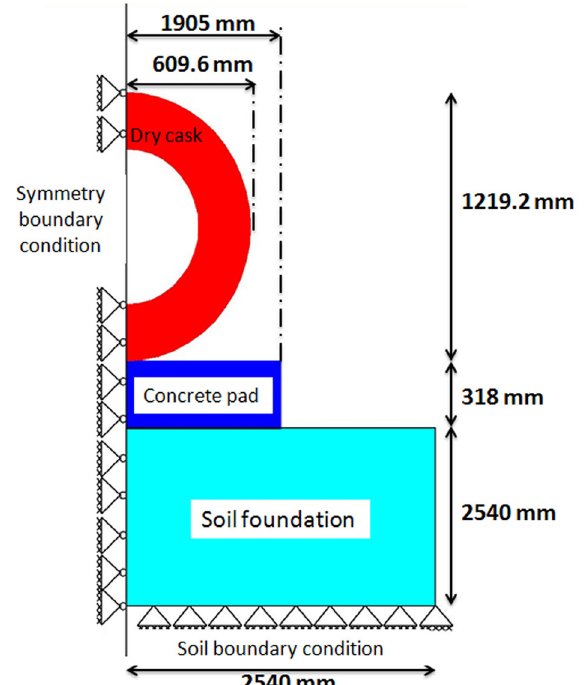
Fig. 14 Boundary conditions for tip-over